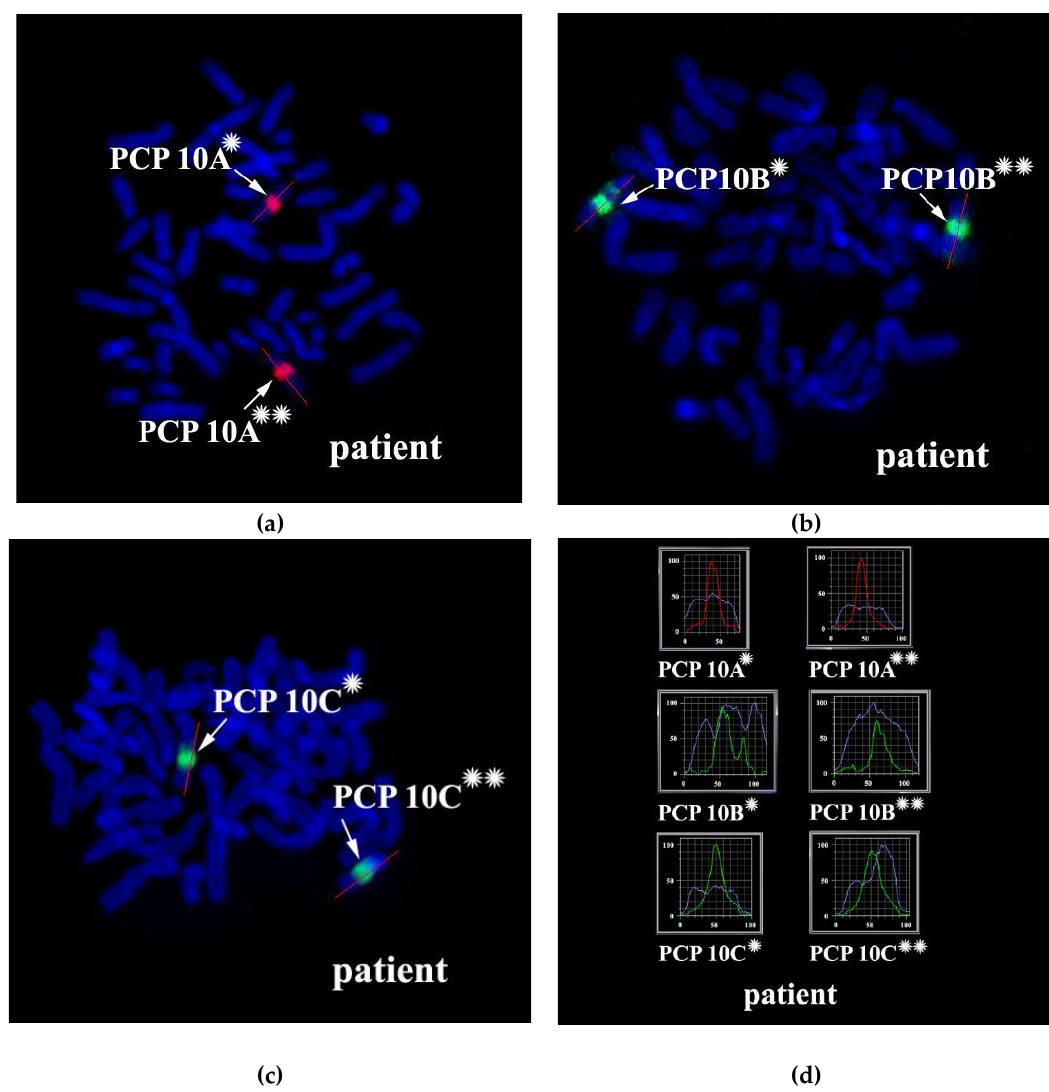
Figure 4. CISS hybridization of microdissected PCPs specific for two regions of human chromosome 10. ( a ) The PCP10A probe (TAMRA-dUTP, red signal); ( b ) the PCP10B probe (Alexa Fluor 488-dUTP, green signal); and ( c ) the PCP10C probe (DEAC-dUTP, green signal) with metaphase chromosomes of the patient. ( d ) Fluorochrome profiles of chromosome 10. An additional signal from PCP10B was found on the long arm of one of the patient’s chromosome 10 homologs. → indicates signals emitted by the PCP probes on chromosome 10. DAPI-stained chromosomes are blue. * and ** correspond to the normal and rearranged homologs,